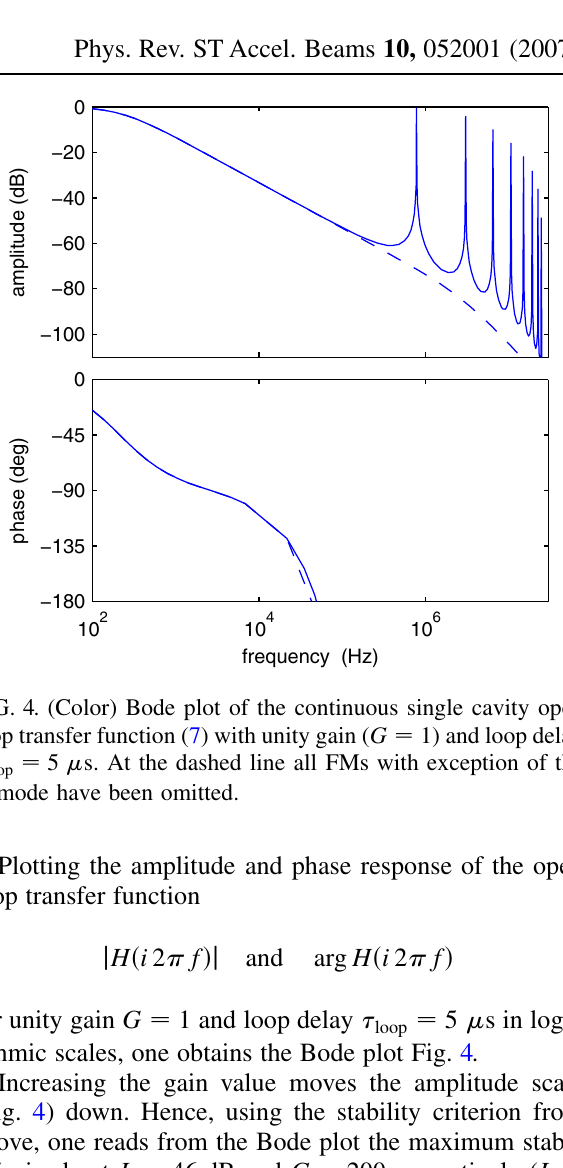
rithmic scales, one obtains the Bode plot Fig. 4.